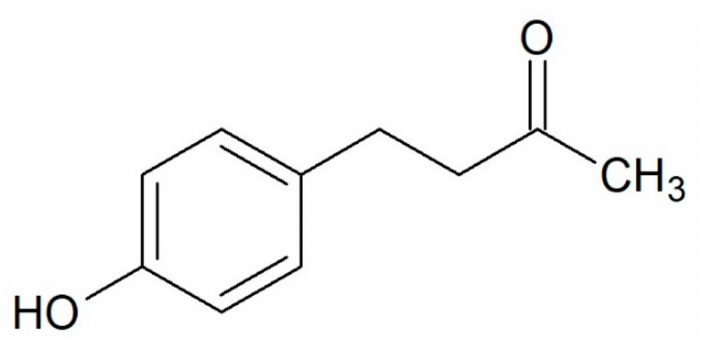
Figure 1. The chemical structure of raspberry ketone